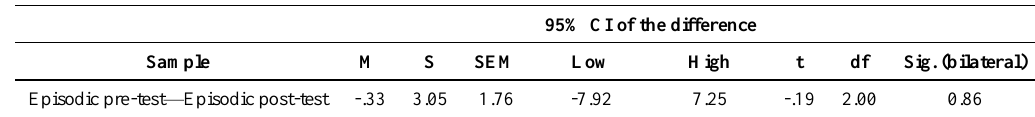
Table 5. Paired sample